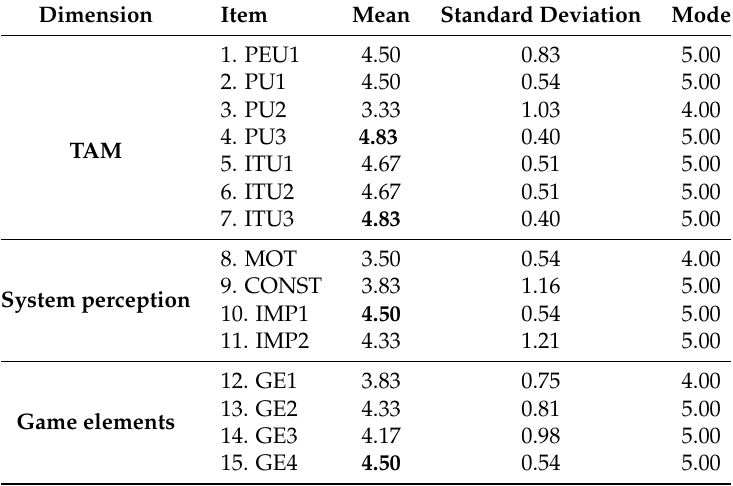
Table 3. Descriptive statistics of the dimensions evaluated by